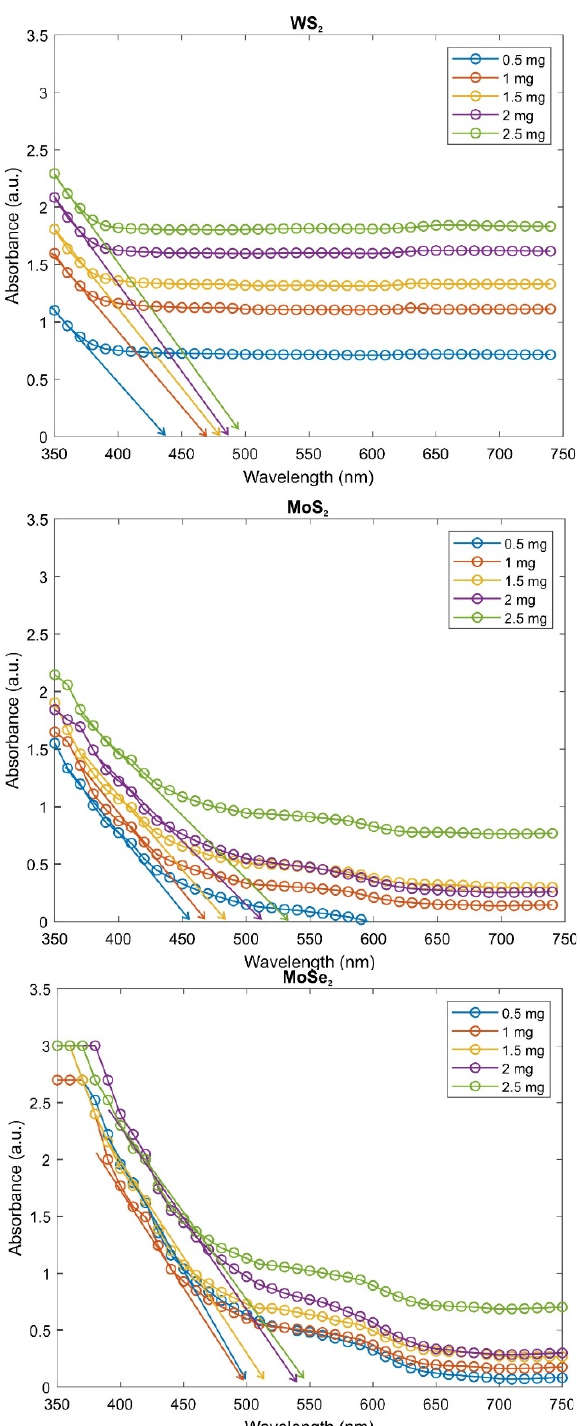
Figure 5. Absorbance versus wavelength graph of WS 2 , MoS 2 , MoSe 2 reinforced PAAm composites from top to bottom, respectively.